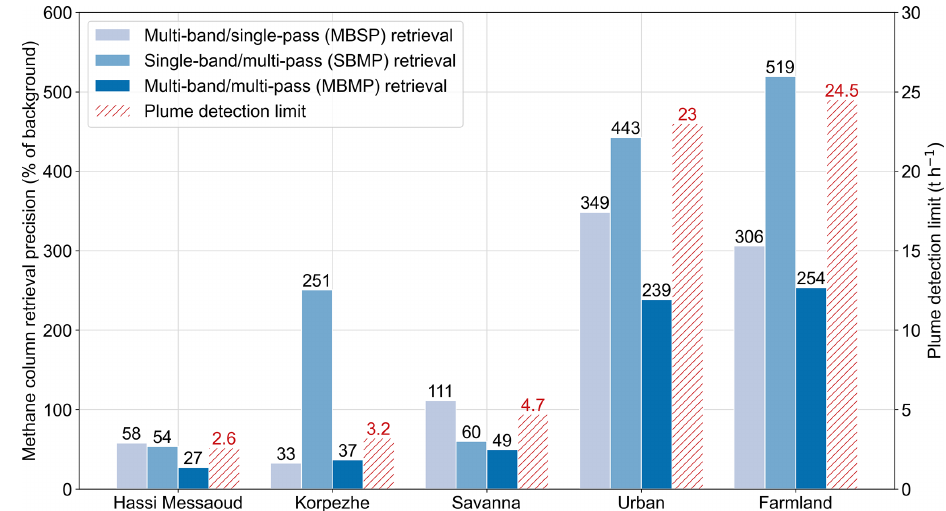
Figure 3. Single-pixel methane column retrieval precision as percentage of background for different scenes and retrieval methods (left axis) and estimated lower limit for plume detection (right axis). The Hassi Messaoud and Korpezhe precisions are averages over all 68–101 satellite passes for those scenes (see Sect. 4). Detection limits for Hassi Messaoud and Korpezhe are determined from observations (see Sect. 4). Detection limits for the savanna, urban, and farmland scenes are obtained by linear scaling of the Hassi Messaoud detection limit for MBMP